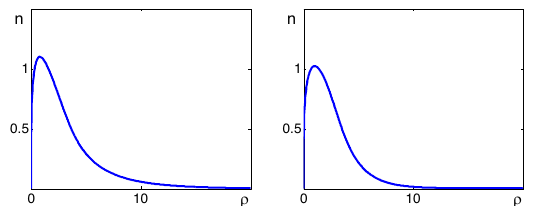
Fig. 1. Spatial distribution of stationary plasma density obtained at high value of normalized amplitude of incident electromag- ) and relatively rarified gas density at the netic wave ( A 0 =4 (cid:5)(cid:23) ). The left panel presents simulation opening output ( 3.0 0 results obtained with ka=1 , the right panels presents simulation results with